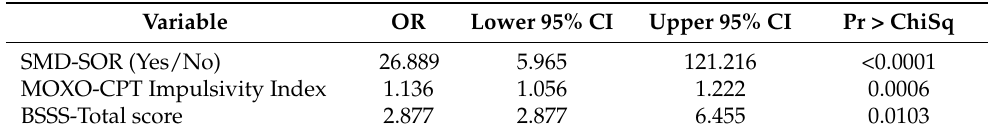
Table 3. The likelihood for SUD by Sensory Over-Responsivity, MOXO-CPT Impulsivity, and